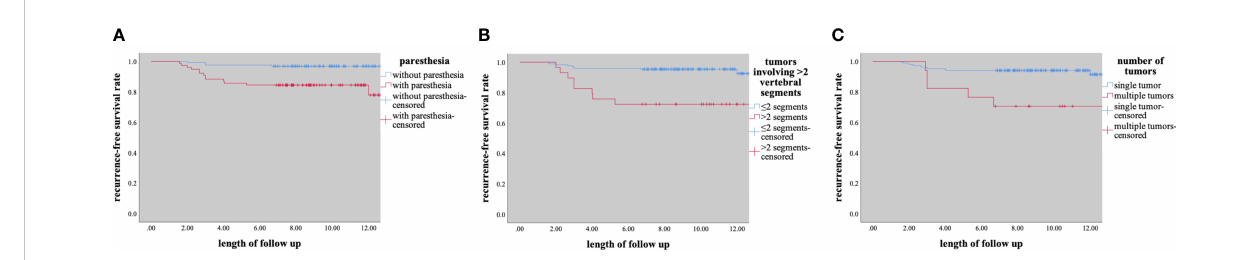
FIGURE 3 Kaplane-Meier curves of recurrence for (A) paresthesia, (B) tumors involving ≥ 2 segments, (C) number of